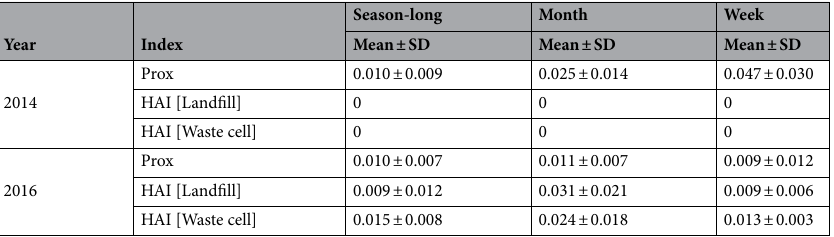
Table 4. Mean and standard deviation (SD) of frequency of wild pig ( Sus scrofa ) locations that were within 10 min and 50 m apart (Prox) and half-weight association (HAI) indices during periods of simultaneous use within the landfill footprint (HAI [Landfill]) and the waste cells within the landfill footprint (HAI [Waste cell]) across time periods (Season-long [ n season = 2; n pigs = 14], Month [ n months = 6; n pigs = 18], Week [ n weeks = 26; n pigs = 17]) for pigs tracked on the Savannah River Site, South Carolina, USA, in 2014 and